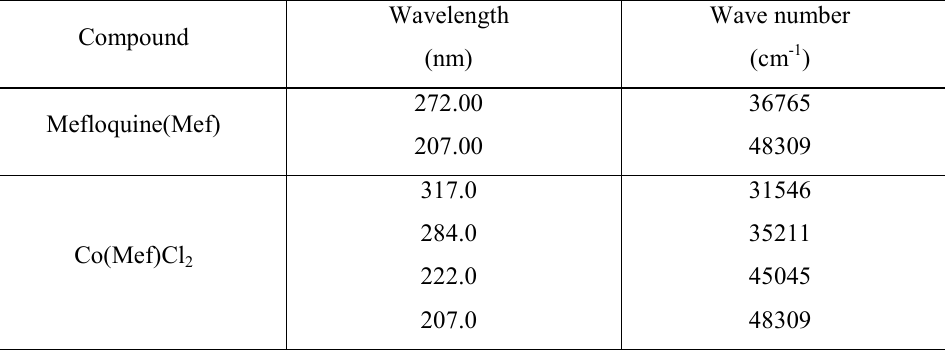
Table 2. Ultraviolet/Visible spectral assignment of mefloquine and its metal complex.